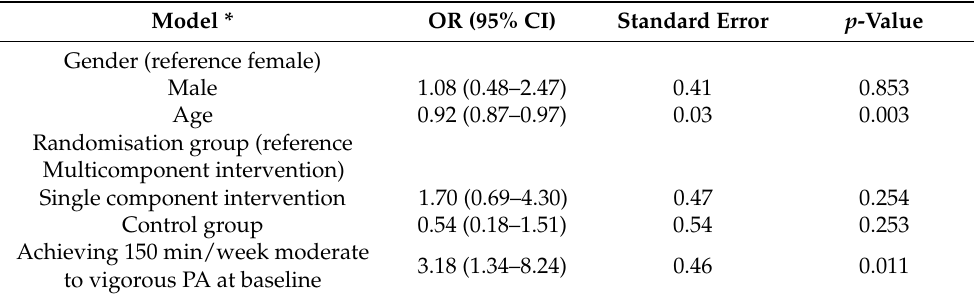
Table 3. Logistic regression analysis to model profile